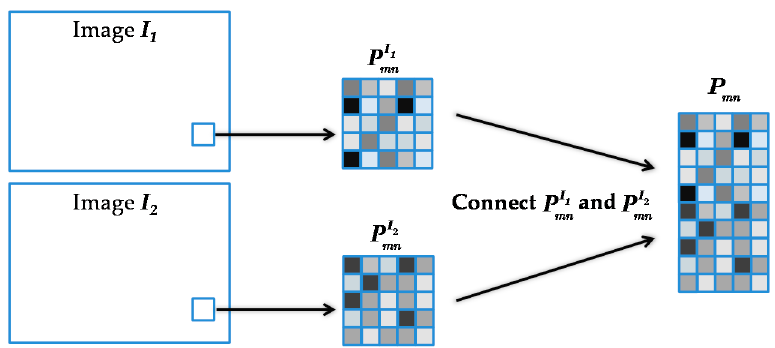
Figure 4. Neighborhood patches generation process.